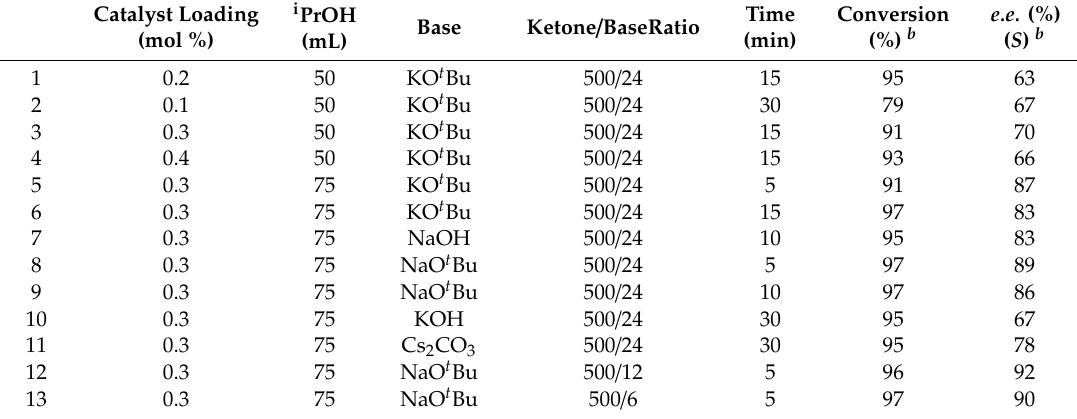
Table 2. Optimization of Reaction Conditions for Transfer Hydrogenation of Acetophenone